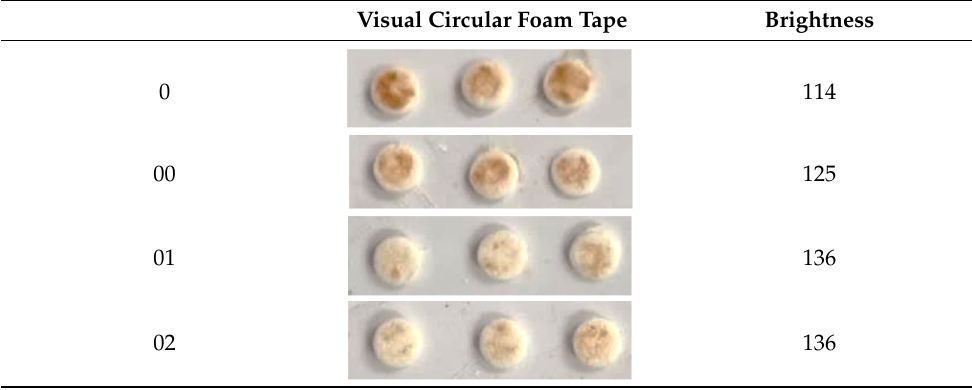
Table 3. Results of the efficacy tests carried out on the specimens prepared in laboratory.